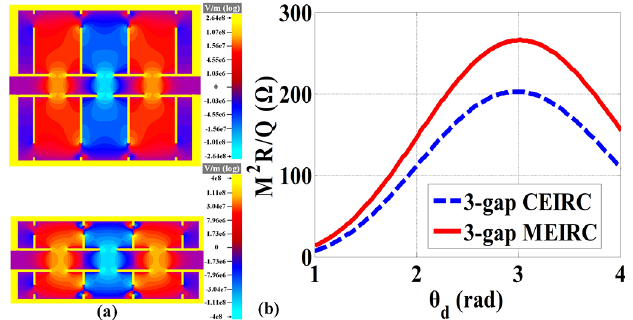
Fig. 4. Simulated and calculated results. (a) Fundamental mode longitudinal electric fi eld contours of the 3-gap conventional EIRC (upper) and the 3-gap MTM EIRC (lower), and (b) M 2 R/Q versus gap transit angle [48].